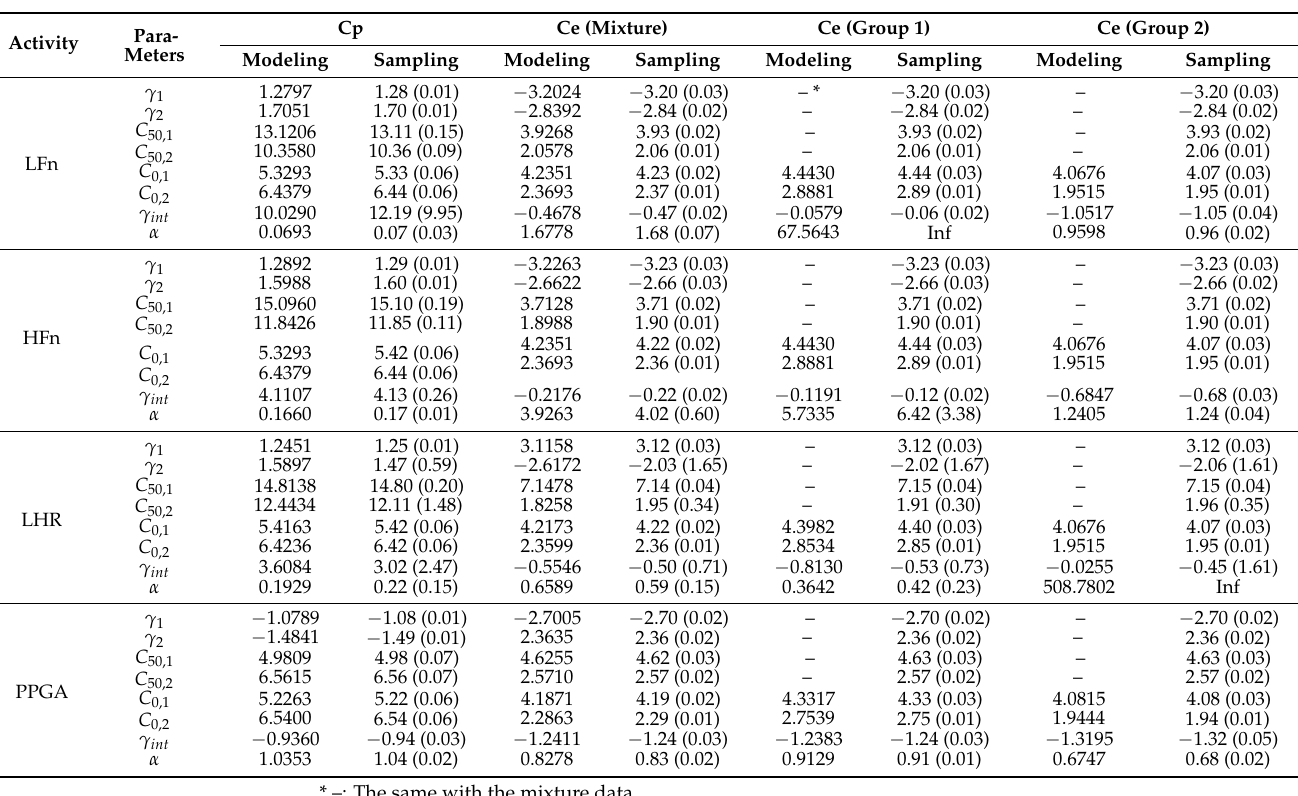
Table 2. The modeling and sampling parameters of the propofol–fentanyl interaction MLRSM.